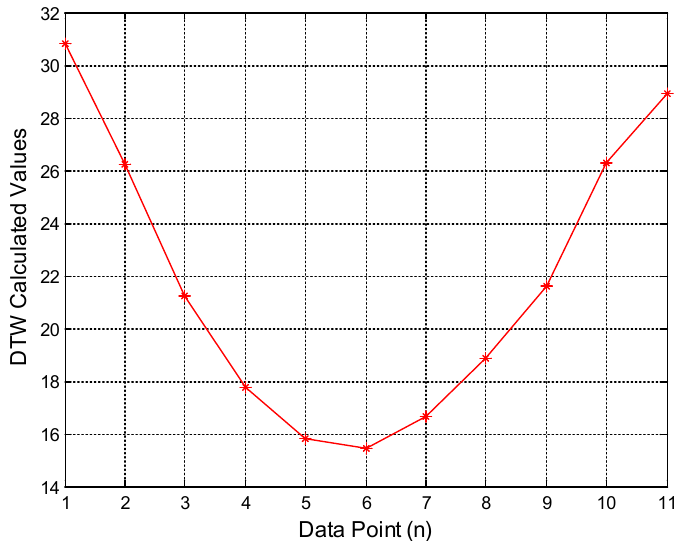
Figure 10. The DTW-calculated result.